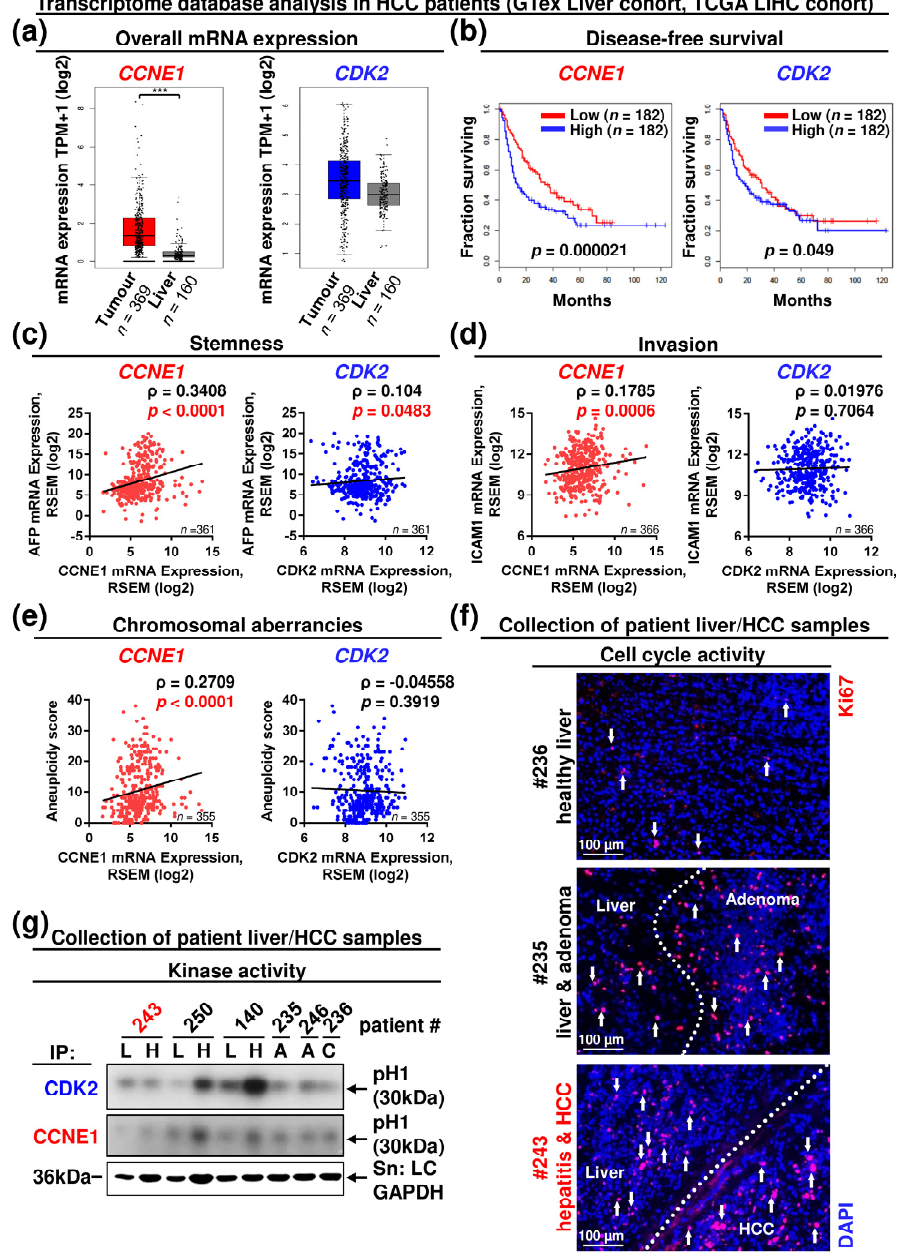
Figure 6. The CCNE1 but not the CDK2 level contributes to a gene signature of dedifferentiation, invasion and chromosomal instability. In silico database analysis of CCNE1 and CDK2 expression in tumour samples and matching tumour-free liver samples of HCC patients based on RNA-seq data generated by the TCGA Research Network, liver hepatocellular carcinoma (LIHC) cohort (http://cancergenome.nih.gov/, n = 373 HCC samples, n = 50 liver samples, accessed on 5 May 2021) and independent tumour-free liver samples ( n = 110) by GTex liver cohort (http://gtexportal.org/, accessed on 5 May 2021). Details are given in the methods section. ( a ) mRNA expression levels of CCNE1 (left) and CDK2 (right) in HCC patients and healthy livers (according to http://gepia2.cancer-pku.cn/, accessed on 5 May 2021). TPM: Transcript per kilobase million. ***: p < 0.001. ( b ) Disease-free survival of HCC patient cohorts (according to http://gepia2.cancer-pku.cn/, accessed on 5 May 2021) with high or low expression of CCNE1 (left) or CDK2 (right). ( c – e ) Linear analysis in human HCC patients. ( c ) Correlation between mRNA expression levels of CCNE1 (left) or CDK2 (right) and AFP mRNA expression. ( d ) Correlation between mRNA expression levels of CCNE1 (left) or CDK2 (right) and ICAM1 mRNA expression. ( e ) Cor- relation between mRNA expression levels of CCNE1 (left) or CDK2 (right) and aneuploidy score (sum of altered chromo- some arms). Corresponding signalling pathways of the target genes are indicated in the headings. ρ : Spearman correlation coefficient, p -values and sample sizes are indicated within diagrams. RSEM: RNA-Seq by Expectation–Maximisation. ( f , g ) Analysis of a small cohort of human hepatocellular carcinoma samples (H) and matching surrounding liver (L) tissues